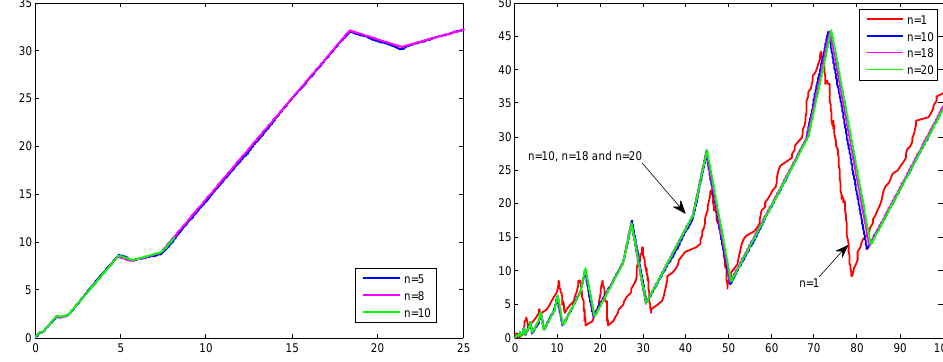
Figure 4: Left: the scaled total queue length process for different n with exhaustive service policy. Right: the scaled queue length process of Q 2 for different n with gated service